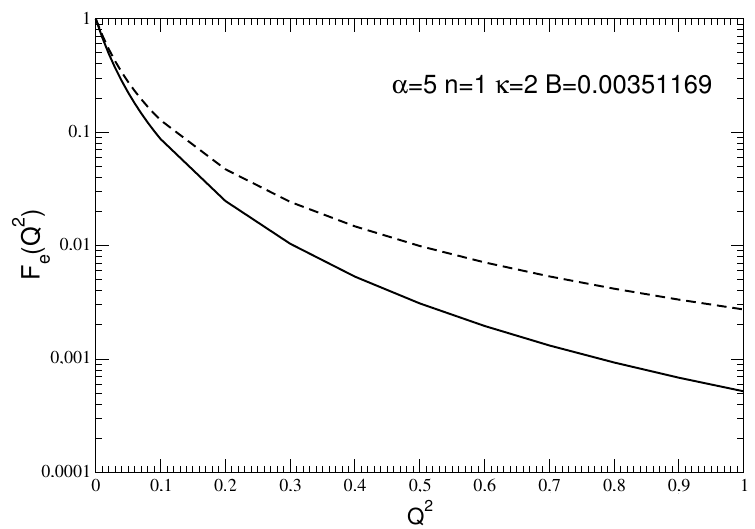
Figure 11. Solid line: abnormal elastic form factor of state No. 3 from Table 1 ( n = 1, κ = 2). The dashed line is the normal elastic form factor of the state with n = 1, κ = 0 with the same binding energy (and, hence, rms radius) as for the solid line. (Adapted from